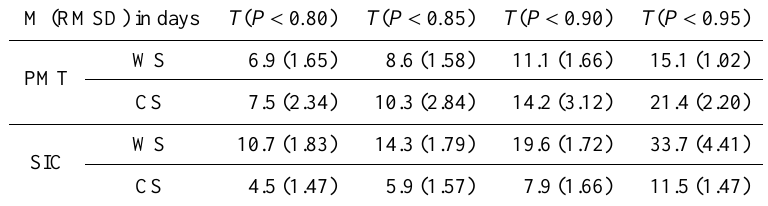
Figure 5. Comparison between some observed and estimated high T-quantiles for two sites: (a) Corleone station in SIC during WS; (b) Torino station in PMT during CS. Table 1. Mean (M) and root mean square di ff erence (RSMD) for some quantiles, for both seasons and both investigated areas.